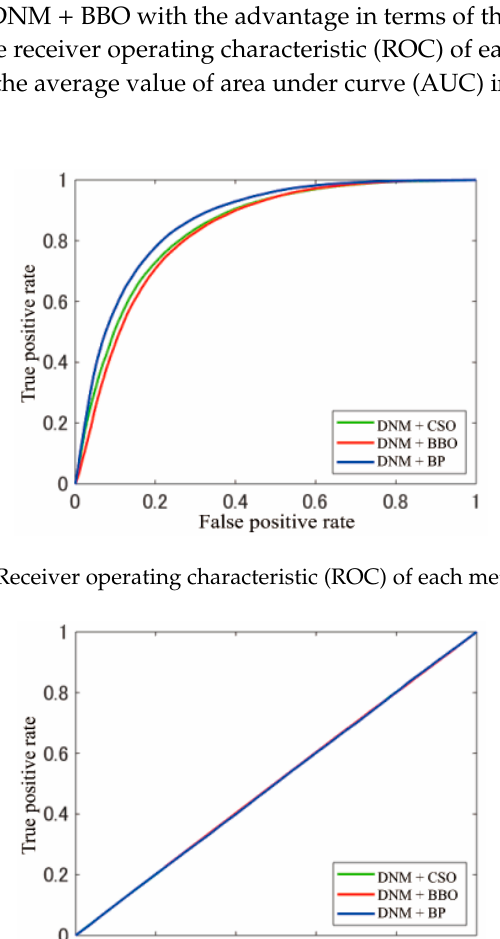
Figure 11. ROC of each method in F3. According to Figures 9 and 11, DNM + BP in F1 and DNM + BBO in F3 obtain the highest classification accuracies. On the other hand, the three methods overlap on the diagonal line in Figure 10, and the results are similar to those in the case of random classification since the value of AUC is very close to 0.5, as shown in Table 18. Table 18. Average area under curve (AUC) for each problem and method. No.